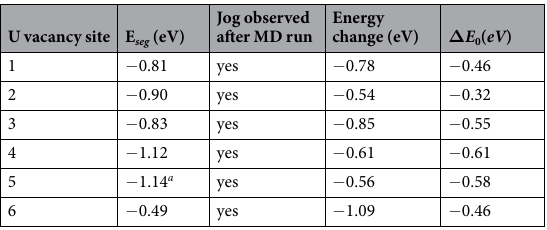
Table 3. The results of MD simulations for a uranium vacancy on a screw dislocation in UO 2 . a metastable jog. E seg is the segregation energy. “Energy change” denotes the change of the total energies between a localized vacancy configuration and dissociated vacancy configuration. Δ E 0 is the energy difference between a dissociated vacancy configuration and the lowest energy among the localized vacancy